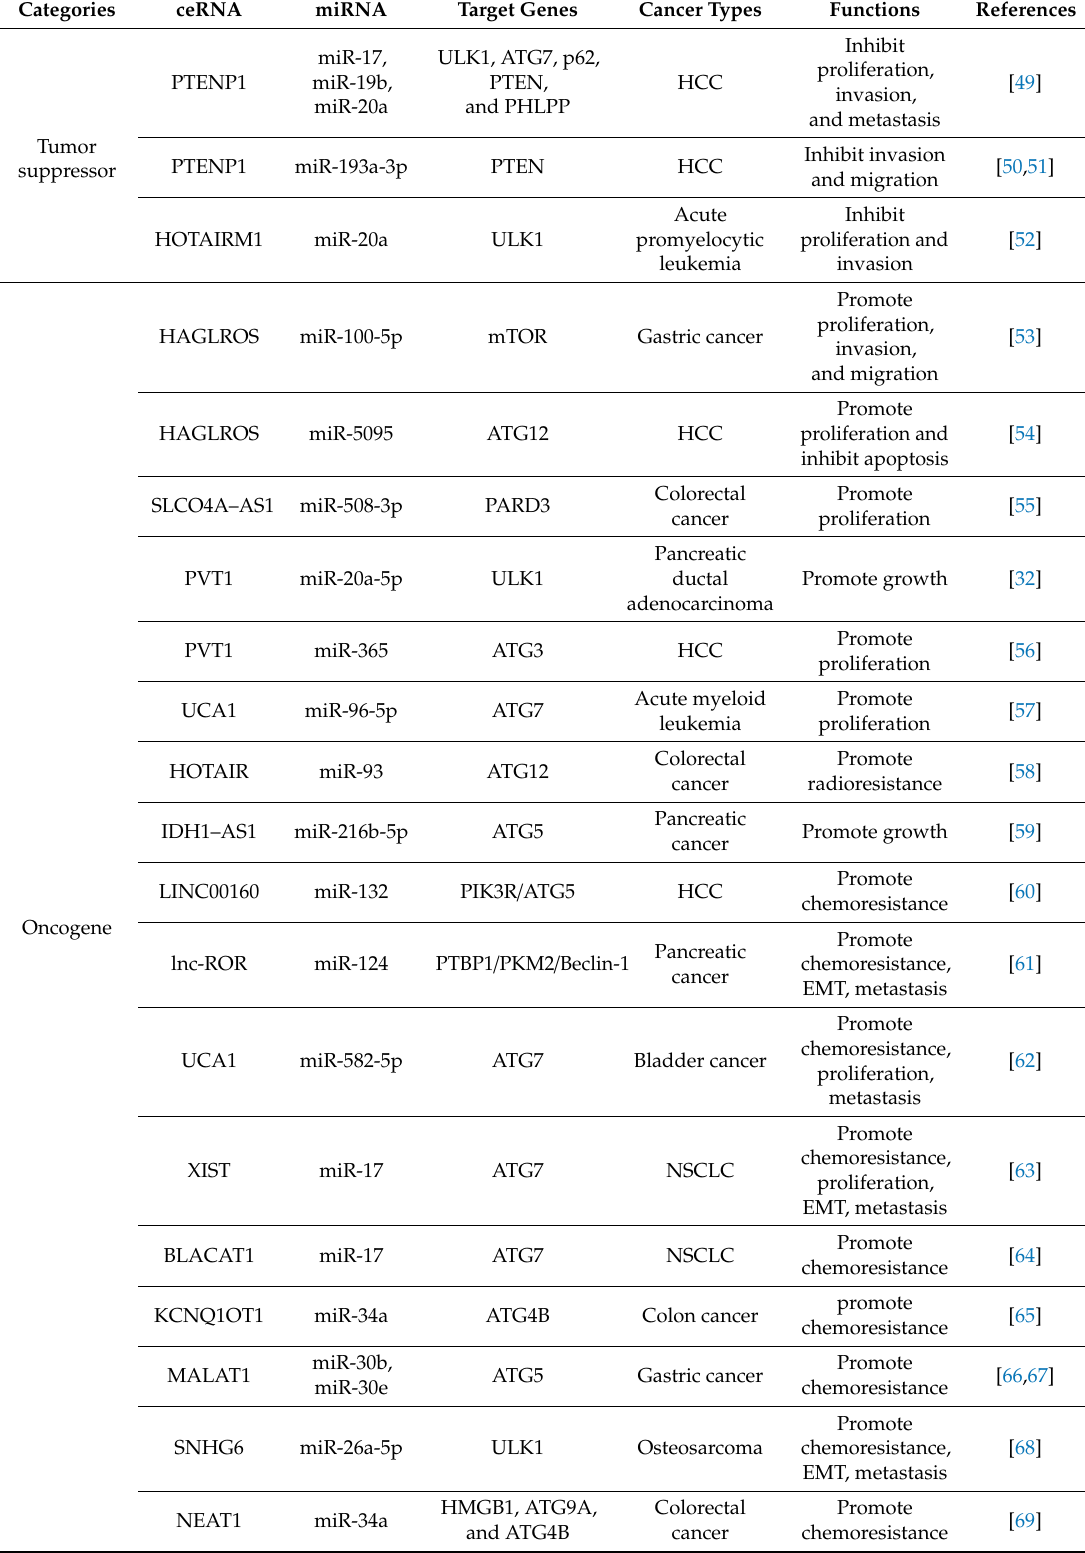
Table 1. ceRNAs regulate autophagy in